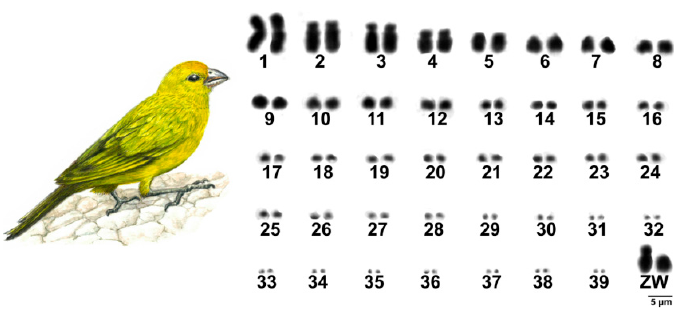
Figure 1. Complete karyotype of a female specimen of Sicalis flaveola 2n = 80.